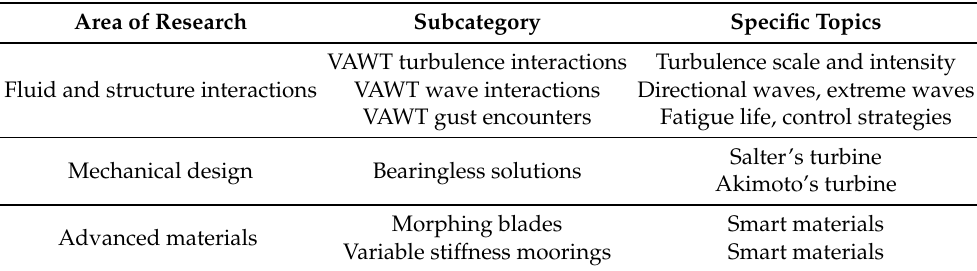
Table 5. Summary of areas of research, subcategories and specific topics to increase the TRL level of offshore floating VAWTs. In the table VAWT refers to floating